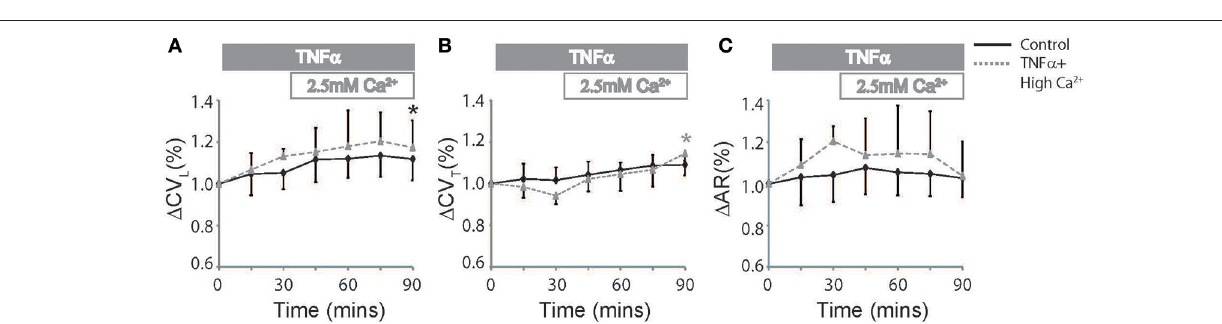
FIGURE 3 | Conduction rescue by high calcium. Percent change in CV L (A) , CV T (B) , and AR (C) over time induced by control Tyrode perfusion and hearts treated with TNF α + high calcium at t > 30mins. Black and gray *Indicates p < 0.05 between t = 0 and 90 mins in control and TNF α perfused hearts respectively by paired